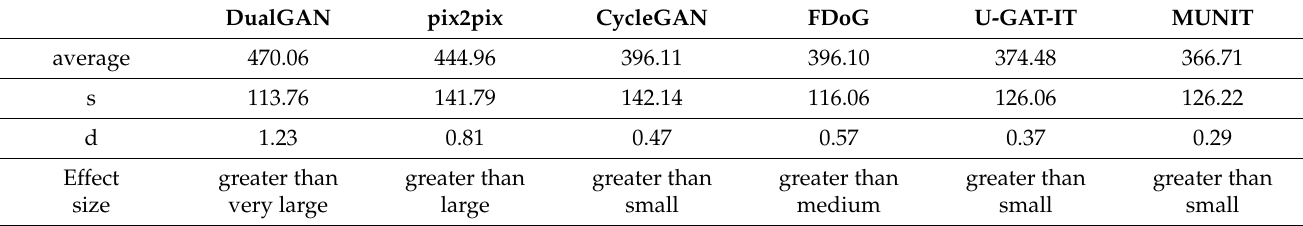
Table 6. Effect size of the FID values estimated by Cohen’s d value. We test twenty samples for the